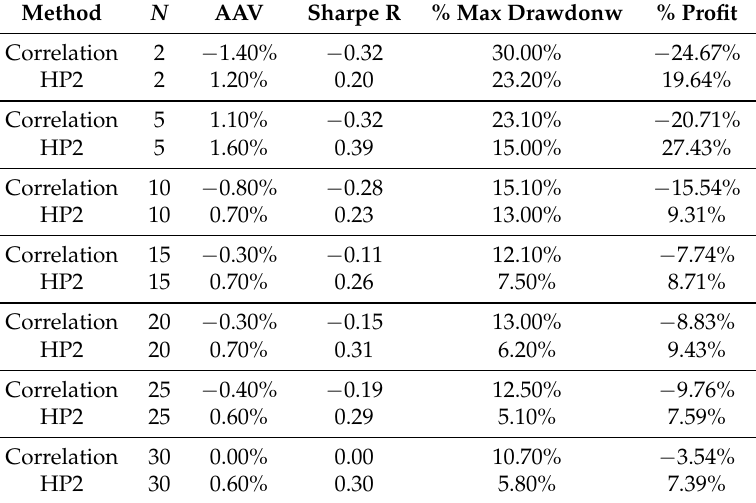
Table 3. Results obtained for the period 2000–2018, where N is the number of pairs; AAV is the average annualized return; Sharpe R is the Sharpe Ratio and Profit is the profitability for the full period with transaction